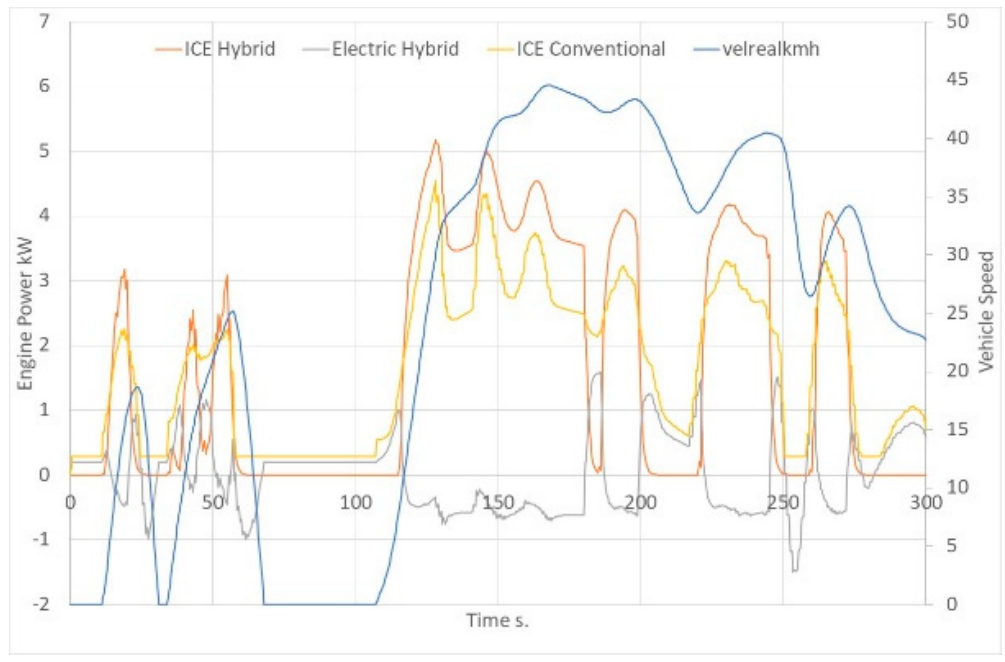
Figure 10. Power output at ICE and electric motor for conventional and hybrid